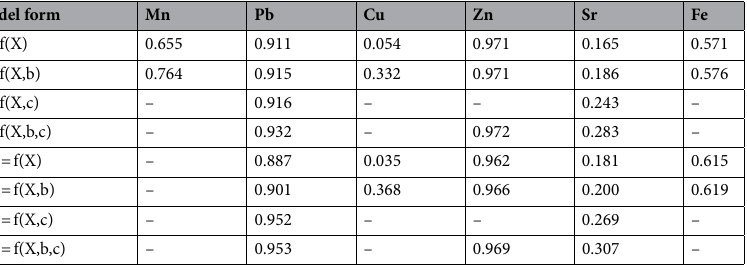
Table 4. Solvable coefficients of different metal models. – indicates “not tested,” where y is the concentration of Pxrf, X the concentration of ICP-MS, B the moisture content value, and C the content of organic matter. X, B, and C include the best value after the transformation via logarithm, index, and power function.